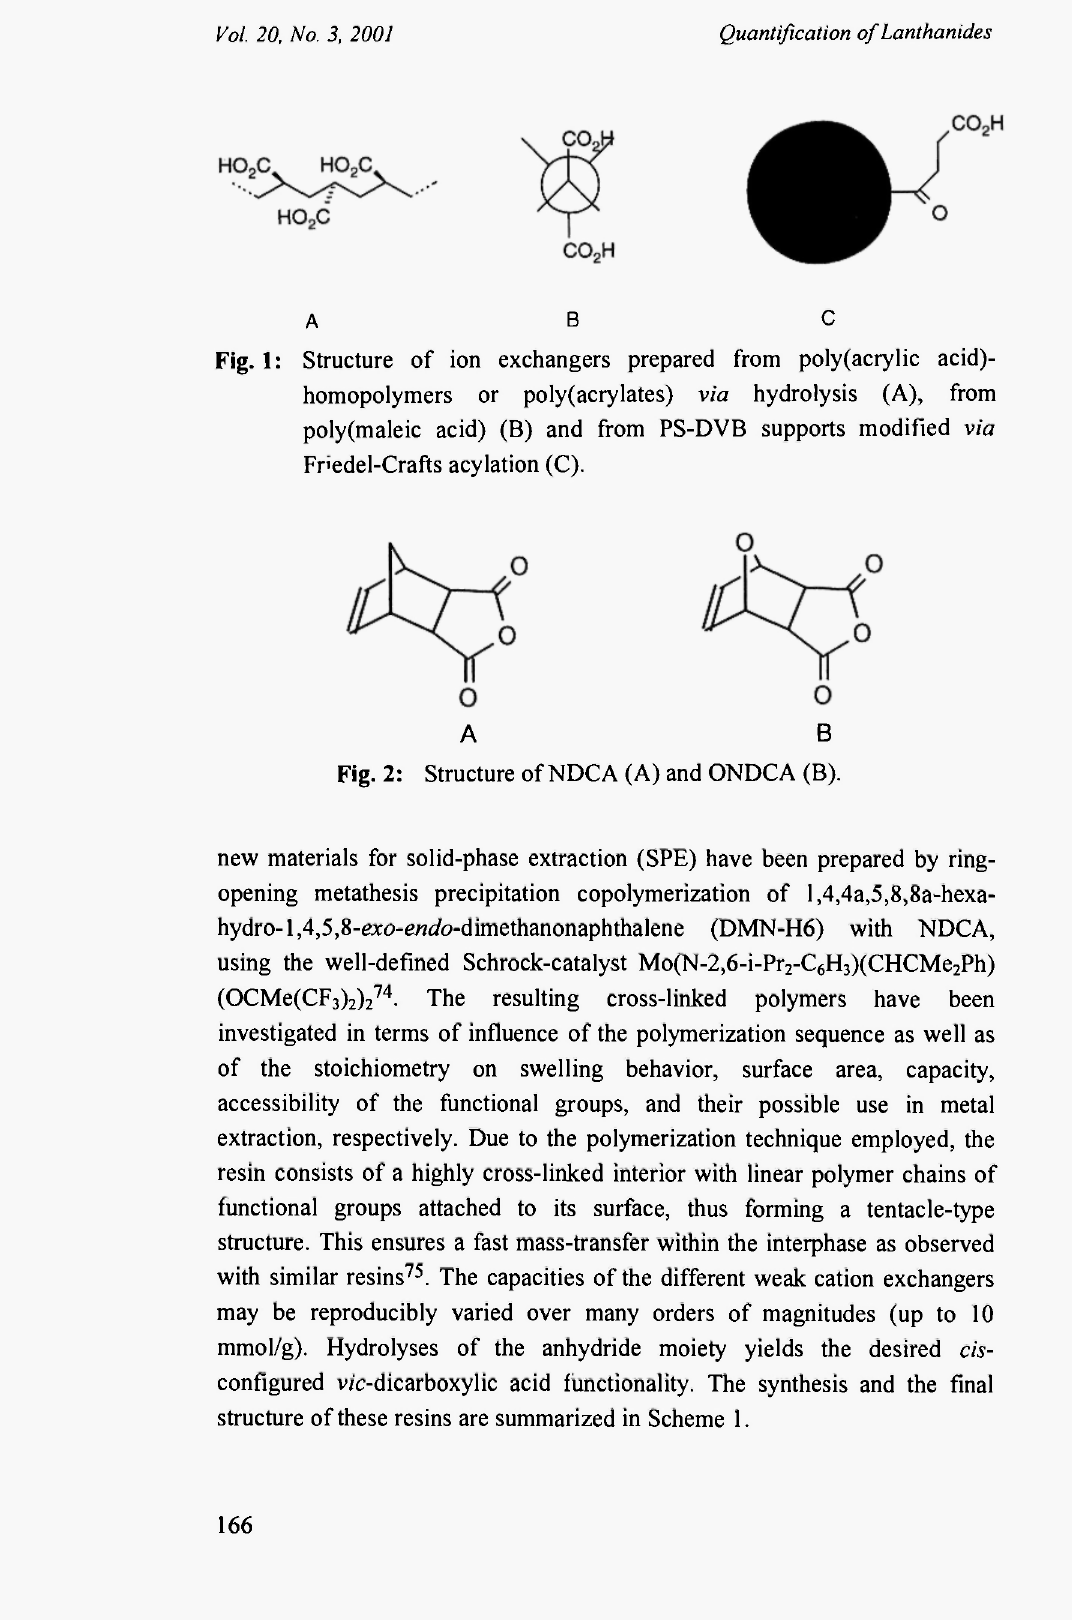
Fig. 1: Structure of ion exchangers prepared from poly(acrylic acid)- homopolymers or poly(acrylates) via hydrolysis (A), from poly(maleic acid) (B) and from PS-DVB supports modified via Fnedel-Crafts acylation (C).